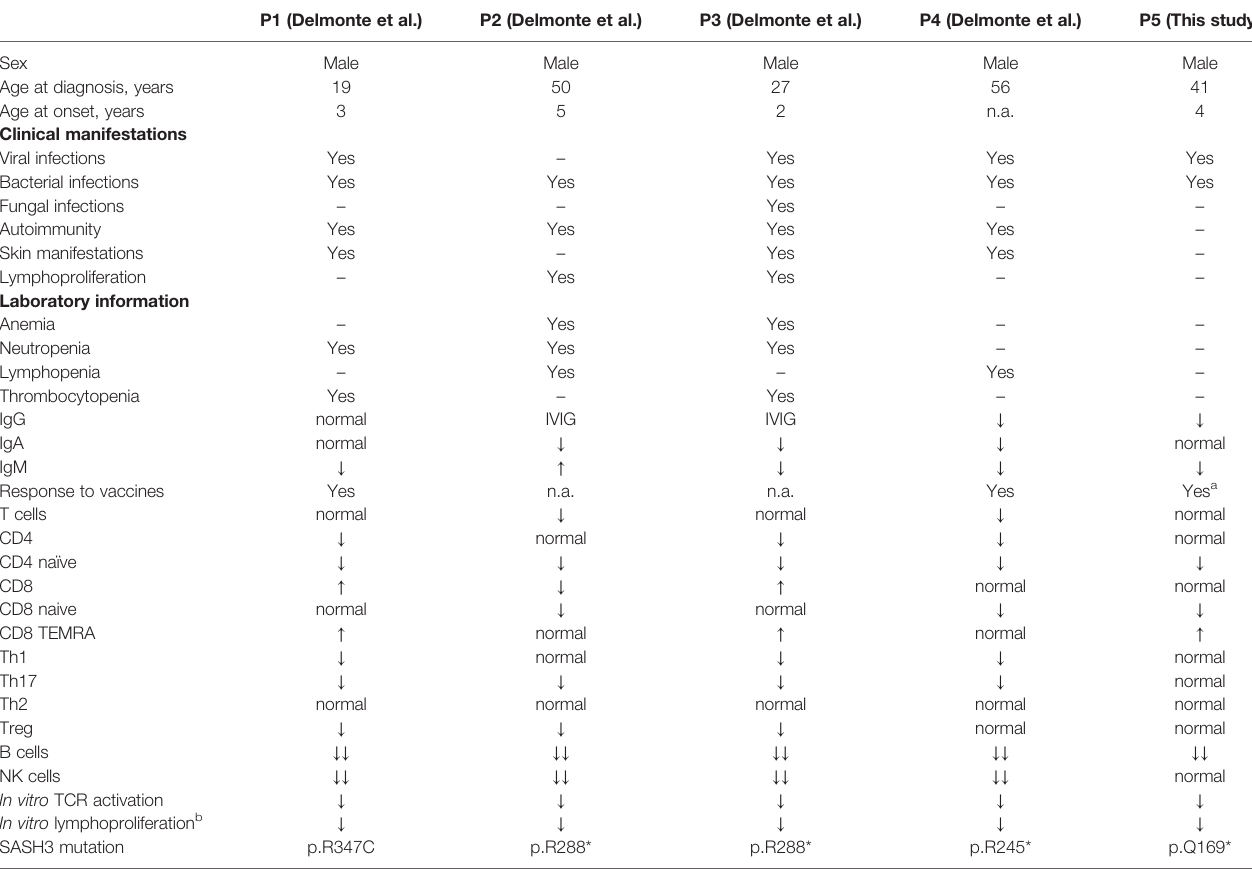
TABLE 2 | Clinical and immunological features of all reported SASH3 de fi cient patients. P1 (Delmonte et